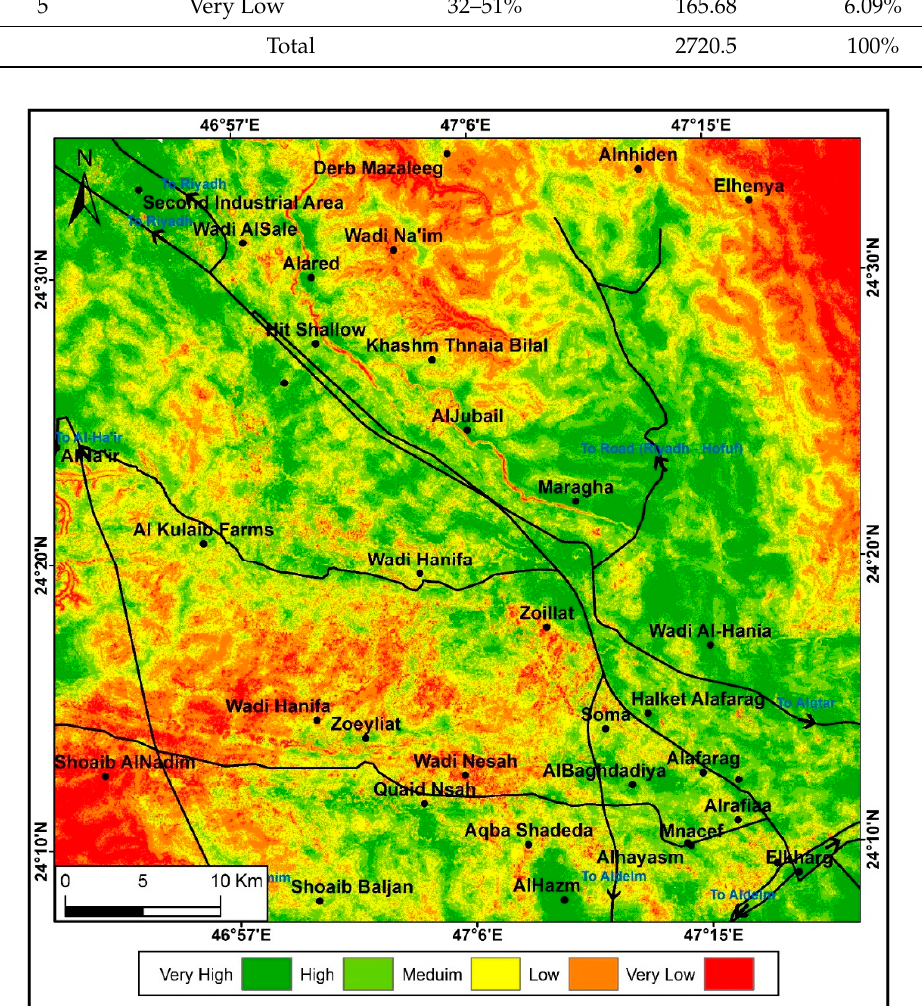
Figure 12. The final spatial suitability map for sustainable urban development in the rural–urban continuum (Ar Riyadh–Al Kharj), 2019.